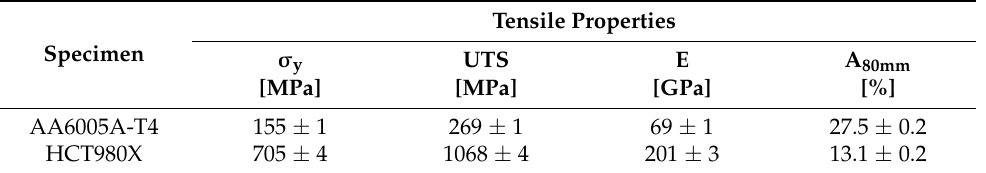
Table 2. The results of tensile tests according to the DIN EN ISO 6892-1 Process A and tensile specimen H 20 × 80 in the rolling direction according to the DIN 50125: yield strength ( σ y ),